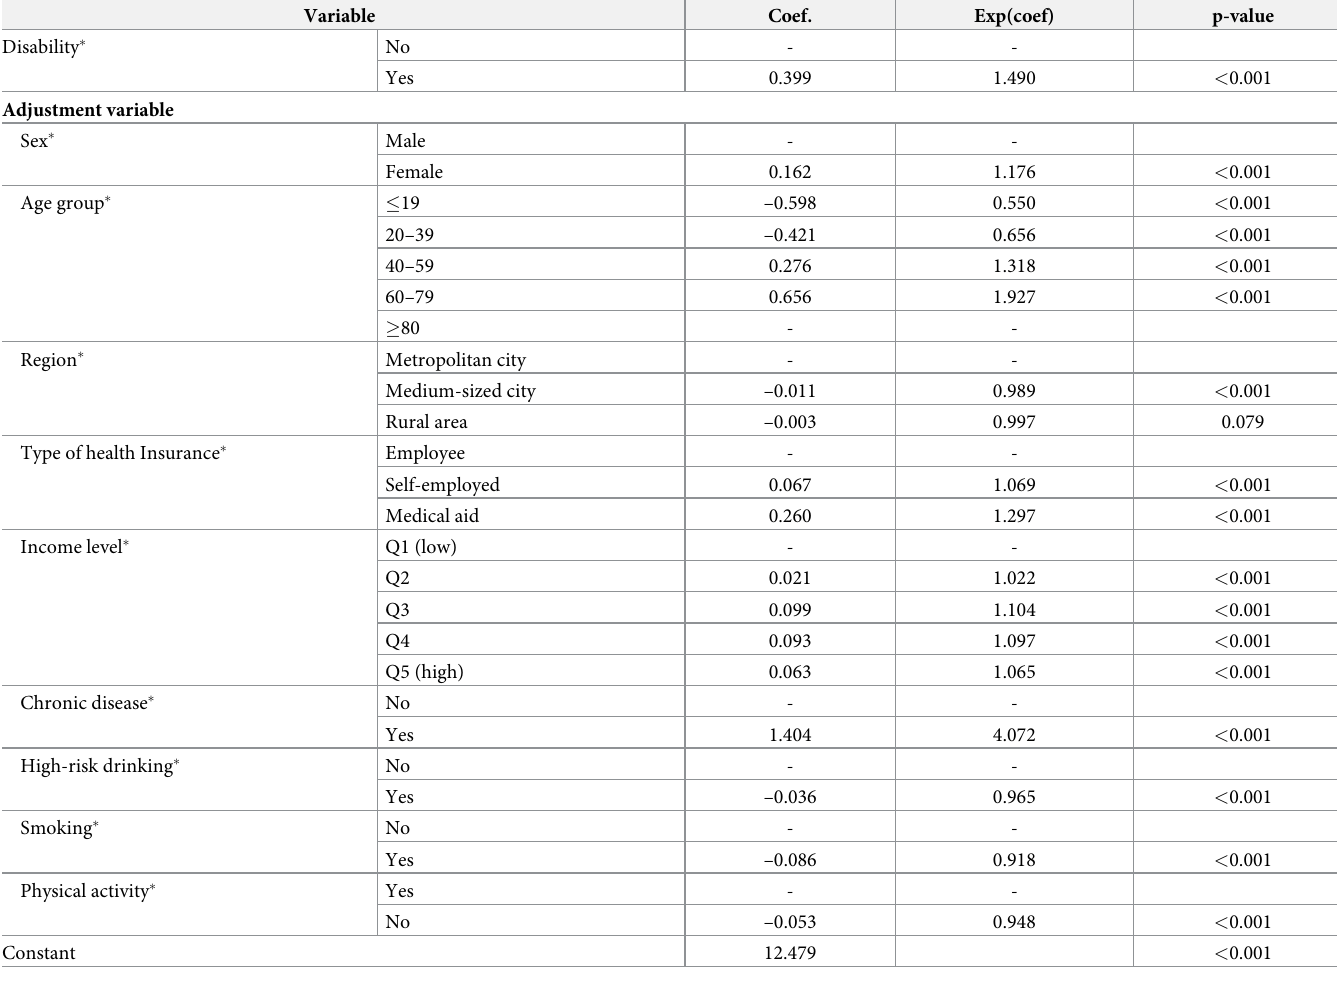
Table 4. Effect of disability on medical care cost per person: Multiple linear regression